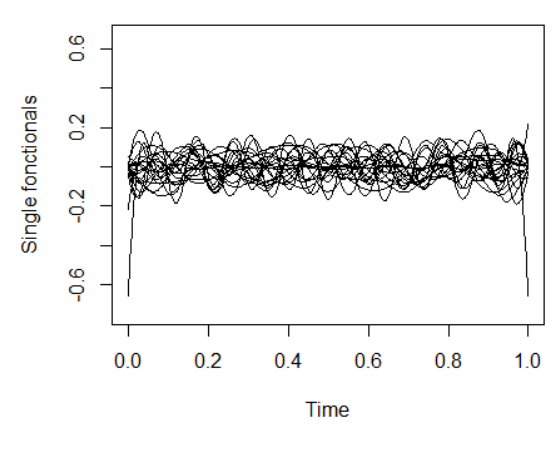
Figure 3: The curves θ i =1, ... ,20 (cid:0) t j (cid:1) , t j ∈ [0,